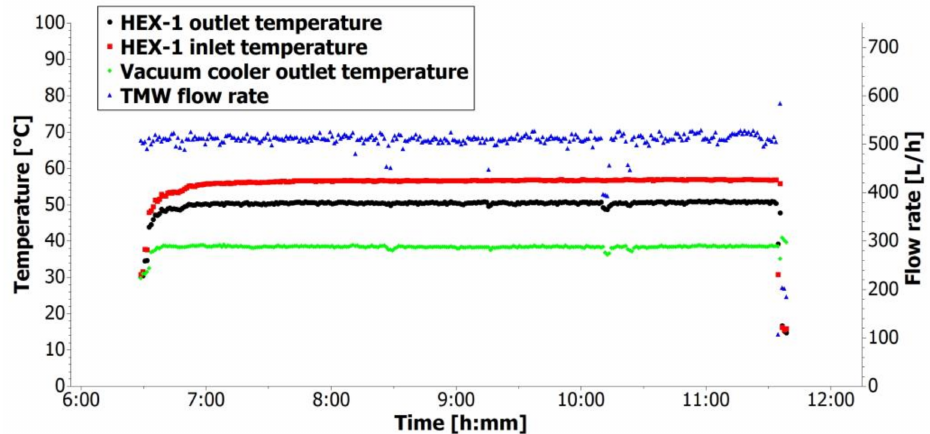
Figure 6. TMW temperature and flow rate history for one day (Mode A).